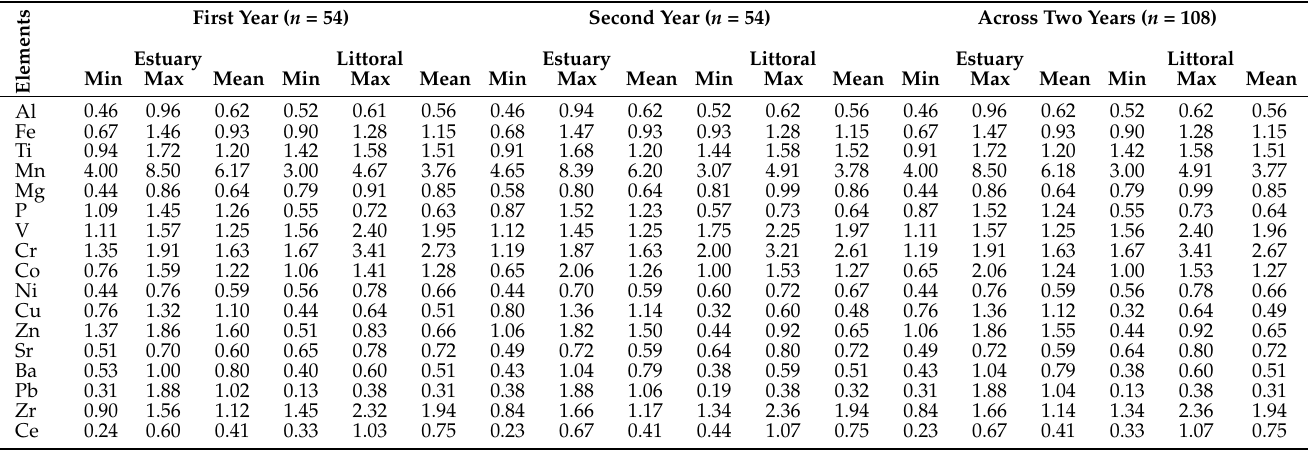
Table 4. The statistical analysis of contamination variables (CF) in sediment